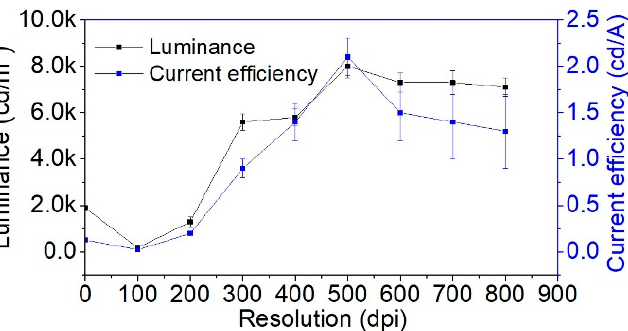
Figure 5. Luminance and current efficiency of PLEDs with the Cs 2 CO 3 interlayer printed with dif- ferent resolutions: 100 dpi, 200 dpi, 300 dpi, 400 dpi, 500 dpi, 600 dpi, 700 dpi and 800 dpi.